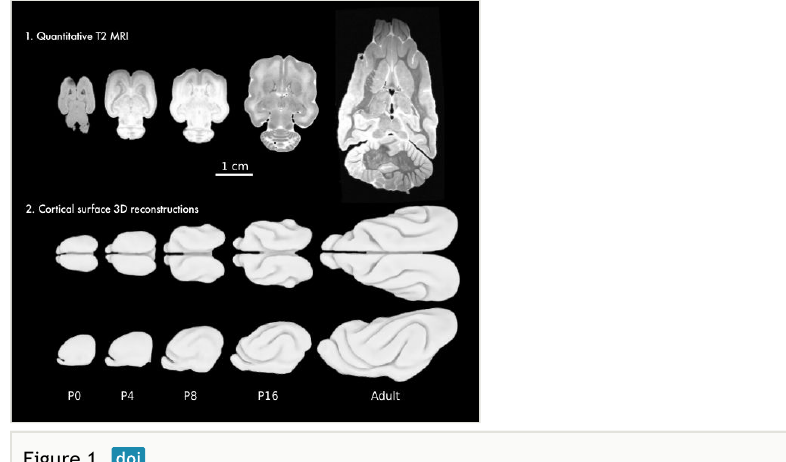
Ferret brain development. (1) Quantitative T2 MRI. (2) Surface reconstructions. The ferret brain is smooth at birth. Brain folding develops during the 1st 2 postnatal